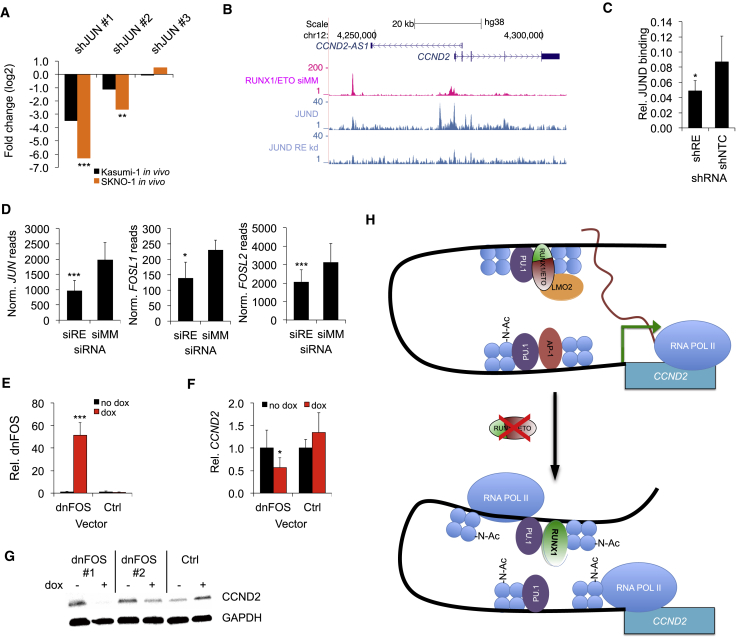
RUNX1/ETO Regulates CCND2 Expression by Promoting AP-1 Activity(A) Log fold change of three JUN shRNA construct levels in in vivo screens in Kasumi-1 and SKNO-1 cells. ∗∗∗p < 0.001; ∗∗p < 0.01 compared with no dox controls.(B) UCSC screenshot showing JUND and RUNX1/ETO binding to the CCND2 locus with and without RUNX1/ETO knockdown in Kasumi-1 cells.(C–E) (C) Manual ChIP validation of JUND binding at the CCND2 promoter with and without RUNX1/ETO knockdown in Kasumi-1 cells. shRE, RUNX1/ETO shRNA; shNTC, non-targeting control shRNA. n = 3; mean ± SD; ∗p < 0.05 compared with shNTC. (D) Changes in transcript levels of JUN and FOS members upon RUNX1/ETO knockdown in Kasumi-1 cells as assessed by RNA-seq. Mean ± SD; n = 3. ∗∗∗p < 0.001; ∗p < 0.05 compared with shNTC. (E) Expression of dnFOS transcript in Kasumi-1 cells lentivirally transduced with dnFOS or control (Ctrl) vector. Cells were incubated for 5 days with and without dox. n = 3; mean ± SD; ∗∗∗p < 0.001.(F) Impact of dnFOS induction by doxycycline in Kasumi-1 cells on relative CCND2 transcript levels measured by qPCR normalized to GAPDH. n = 3; mean ± SD; ∗p < 0.05.(G) Immunoblot showing CCND2 protein levels in Kasumi-1 cells upon dnFOS induction for 5 days. dnFOS#1 and dnFOS#2, FOS overexpressing clones 1 and 2, respectively; Ctrl, normal Kasumi-1 cells.(H) Scheme depicting a model for the regulation of CCND2 by RUNX1/ETO. Depletion of RUNX1/ETO enhances interaction between −30 kb and TSS, increases H3K9 acetylation and occupation of the −30 kb element by RUNX1 and RNA Pol II, impairs AP1 binding at the promoter, and stalls RNA Pol II at the TSS, leading to reduced CCND2 transcription.See also Figure S3.